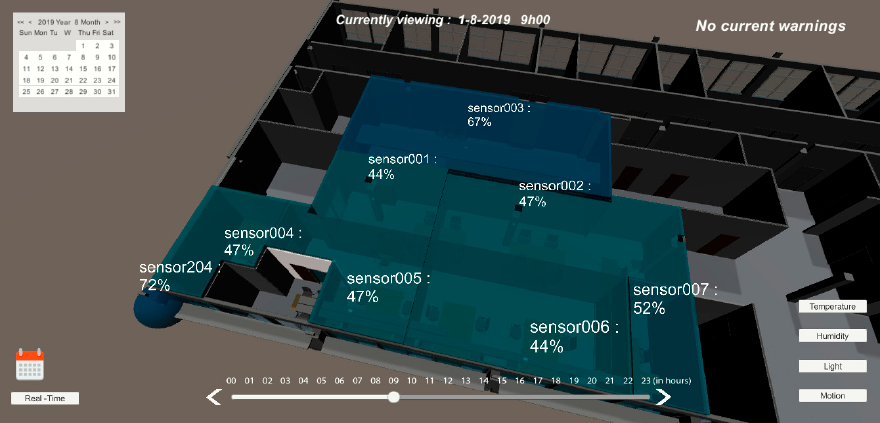
Figure 13. User interface with temperature mode selected for 01-08-2019 at 09:00 h.